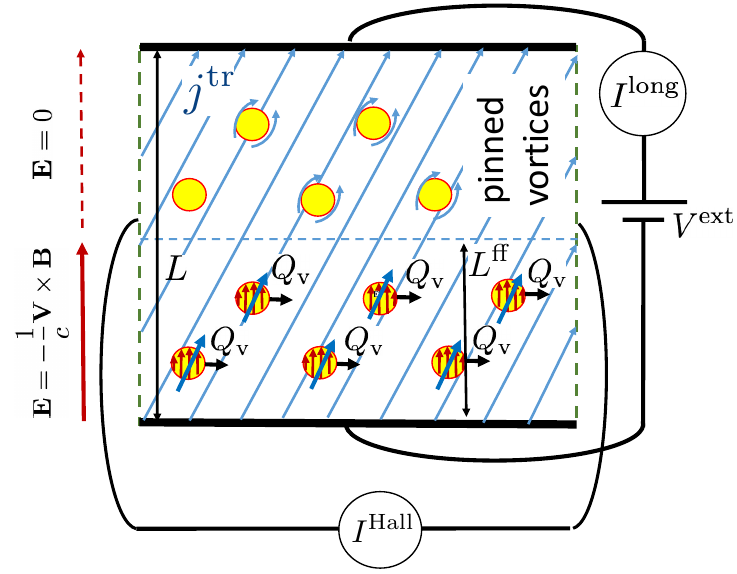
Figure 8: Inhomogeneous flux flow. The pinned vortices do not contribute to the voltage drop, and the transport currents avoid their metallic cores. The external voltage V ext drops only on the flux flow strip of width L ff , which effectively enhances the Bardeen Stephen conductivity by a factor of L / L ff , but not the moving vortex charge contribution, see Eq.